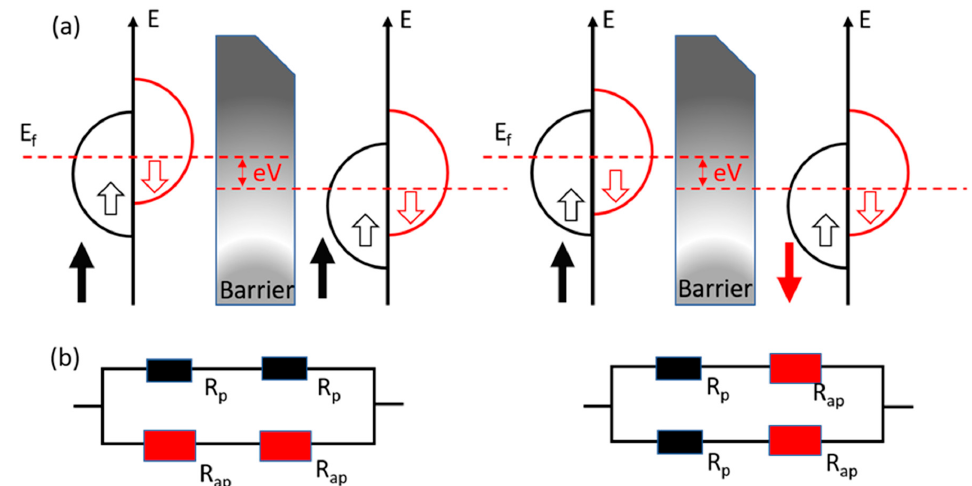
Figure 3. ( a ) Schematic of density of electronic states with parallel magnetization (PM) and antiparallel magnetization (APM). E, the electron energy; E F , the Fermi level; ( b ) Two-current model of tunneling magnetoresistance.